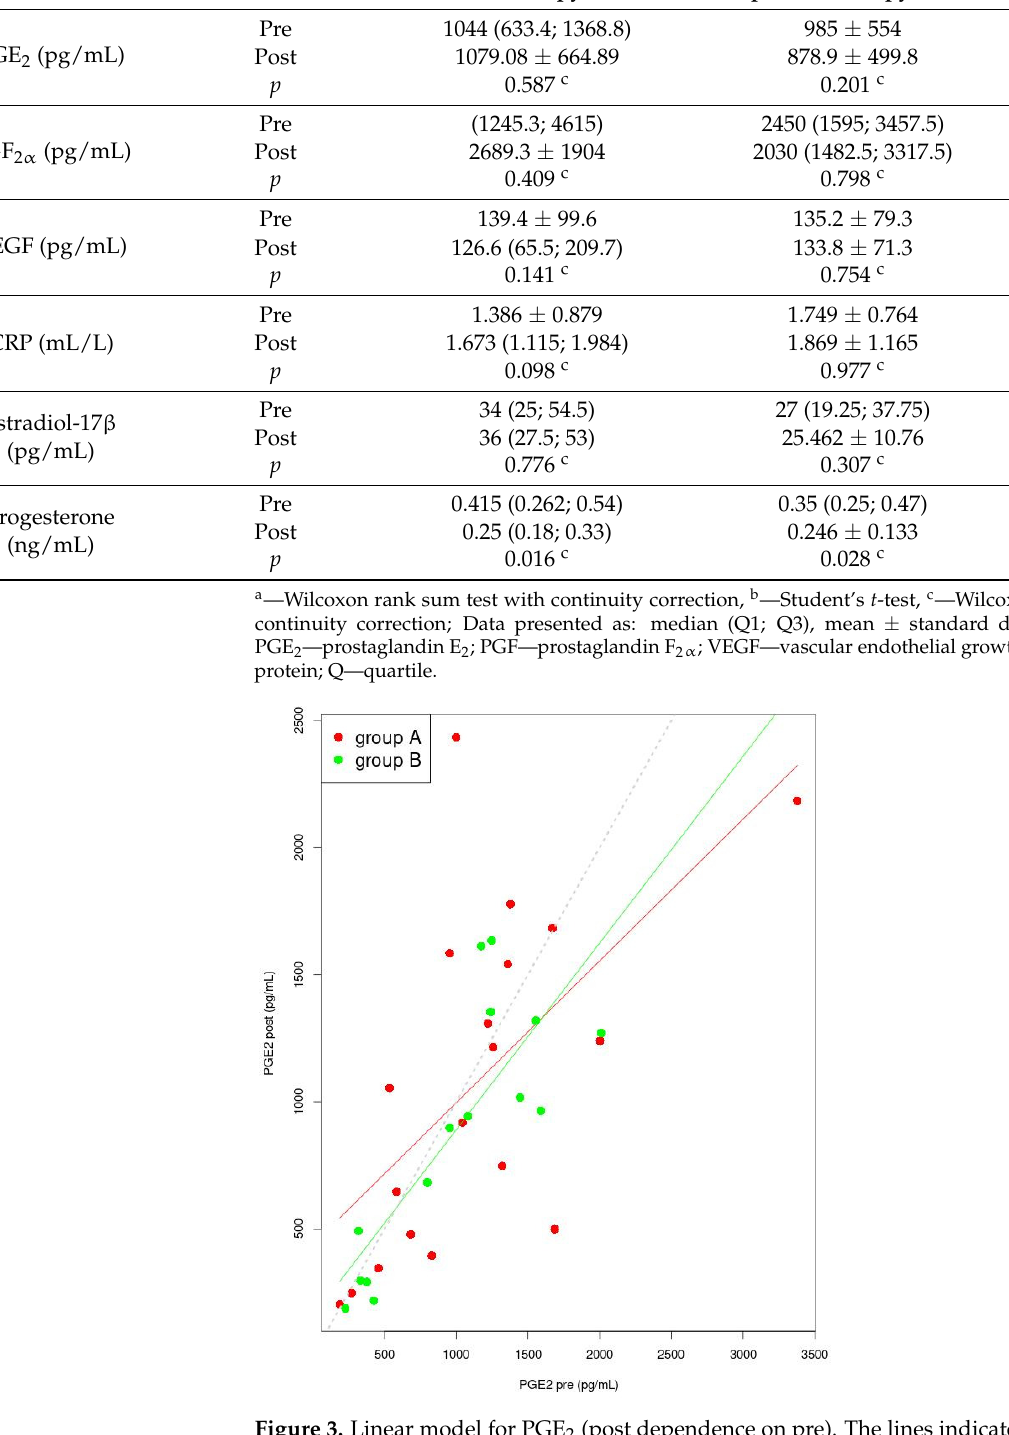
Figure 3. Linear model for PGE 2 (post dependence on pre). The lines indicate the predicted trend of changes of “pre” and of “post” values (red for group A and green for group B). The dashed grey line is the set of points for which the pre and post values are identical. Points for group A were marked in red, while points for group B were marked in green. Abbreviation: PGE 2 —prostaglandin E 2. Table 3. Linear Model for PGE 2 .